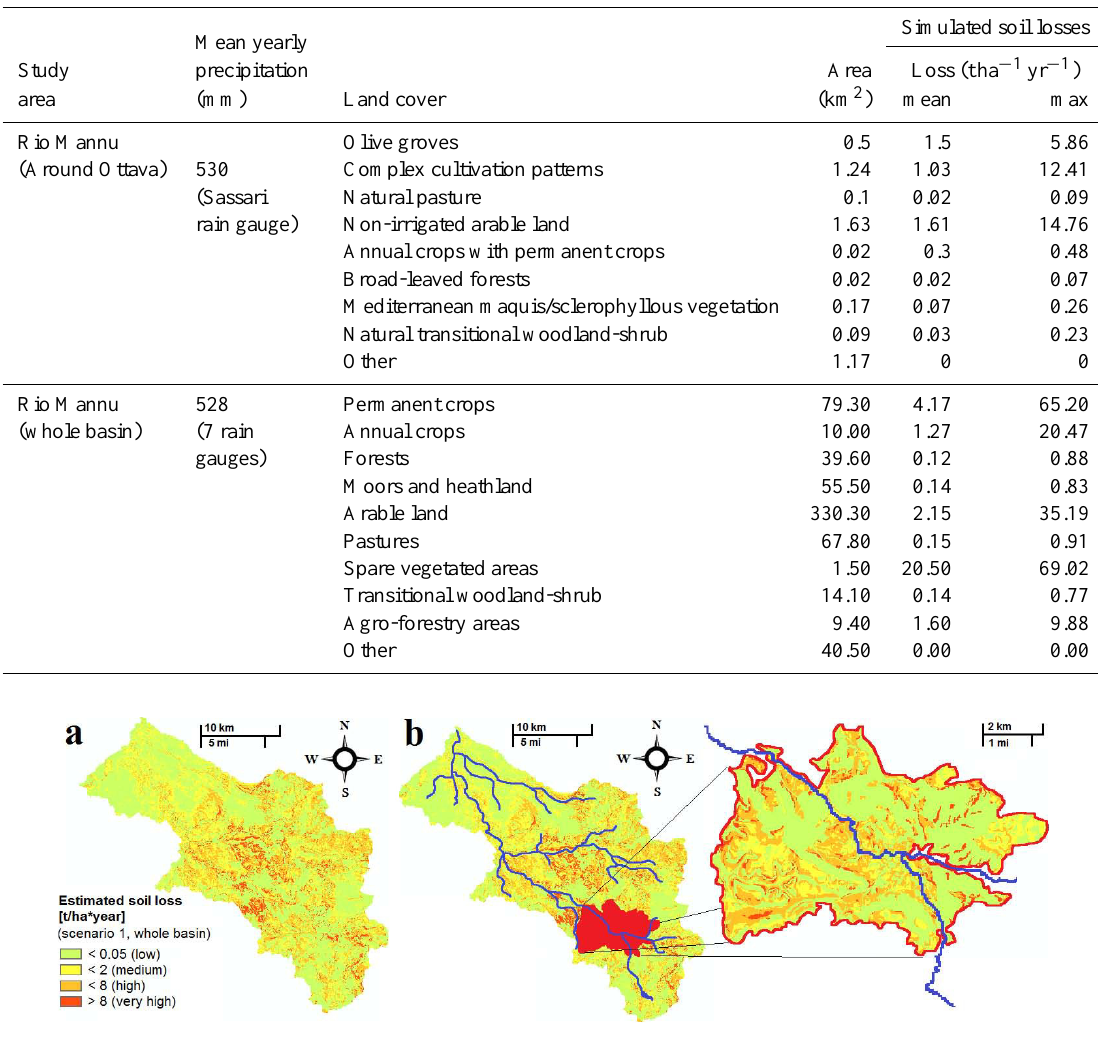
Table 5. Simulated soil losses in the area of Ottava.